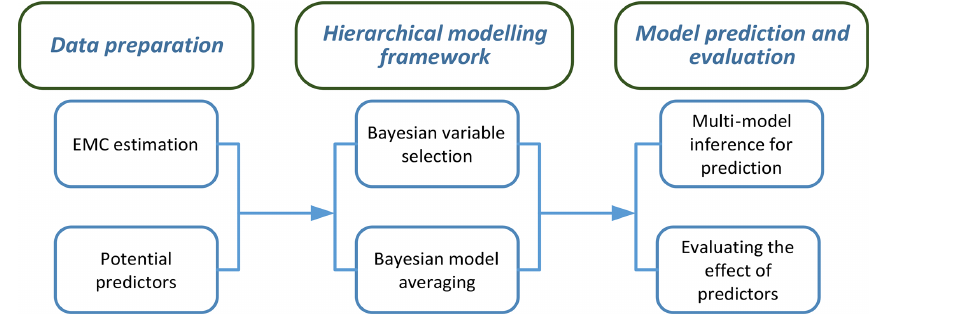
Figure 3. Analyses steps – the detailed methods used in the hierarchical modelling framework and model prediction and evaluation are in the following